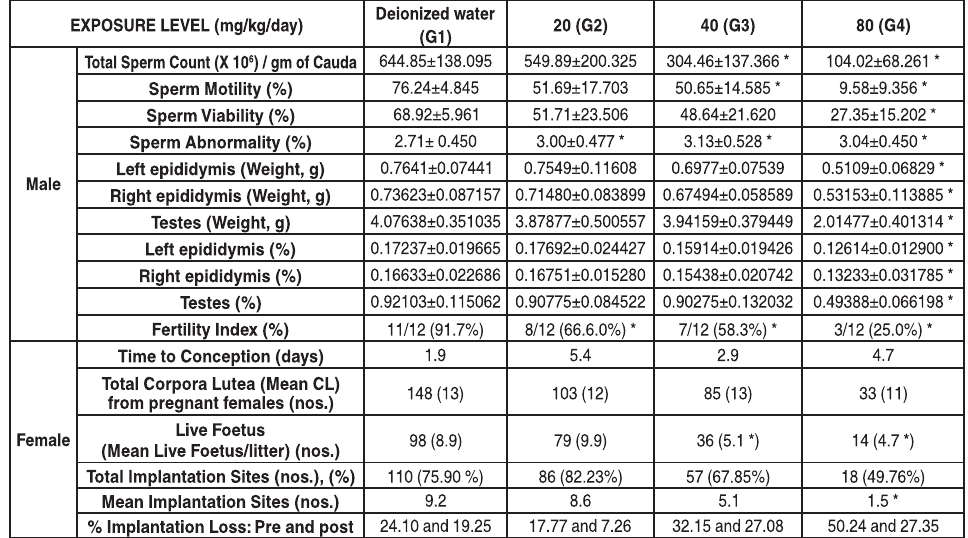
table 1: Major findings on male and female treated with